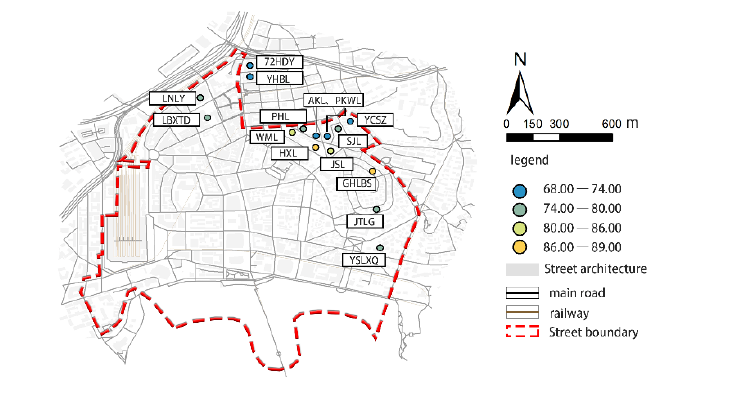
Figure 4. Community with low street walking index.